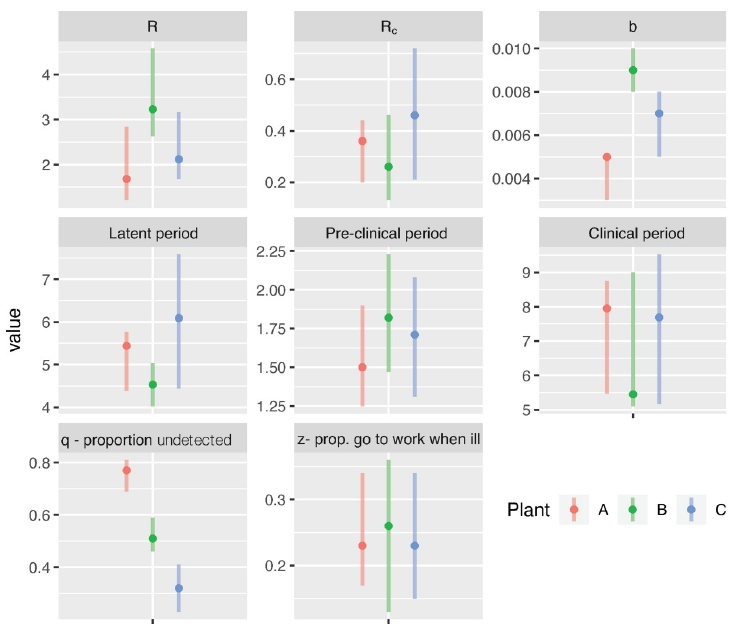
Fig 3. Calibrated model parameters. Comparison of the most-likely value and interquartile range of each parameter value in the tuned models.